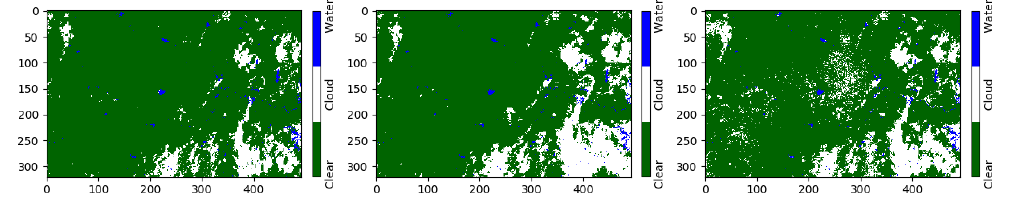
Figure 3. Cloud mask comparison for scene 15 (Table 3) between the manually masked dataset ( left ), the Bayesian cloud mask ( center ), and the operational cloud mask ( right ). The x and y axes labels are the column and row numbers of the cloud mask arrays, included as a reference for image com- parison.